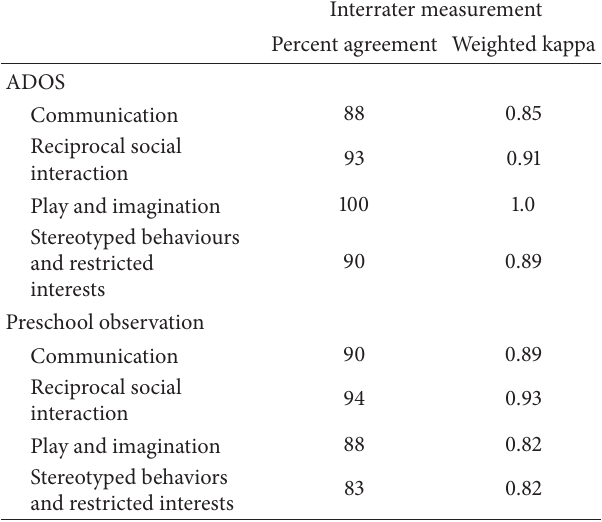
Table 2: Results of Interrater reliability measurements of ADOS ( 𝑛 = 10) and preschool observation ( 𝑛 = 10). Calculated in percent agreement—point-by-point method and weighted